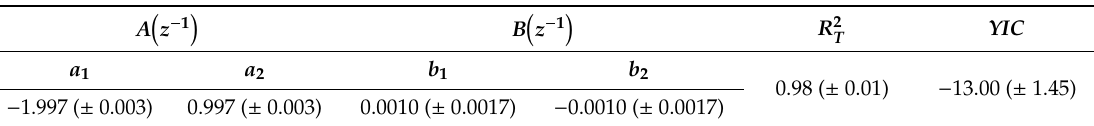
Table 1. The resulted model parameter estimates (average and ± standard error) obtained from 15 incubated eggs at embryonic day (ED)